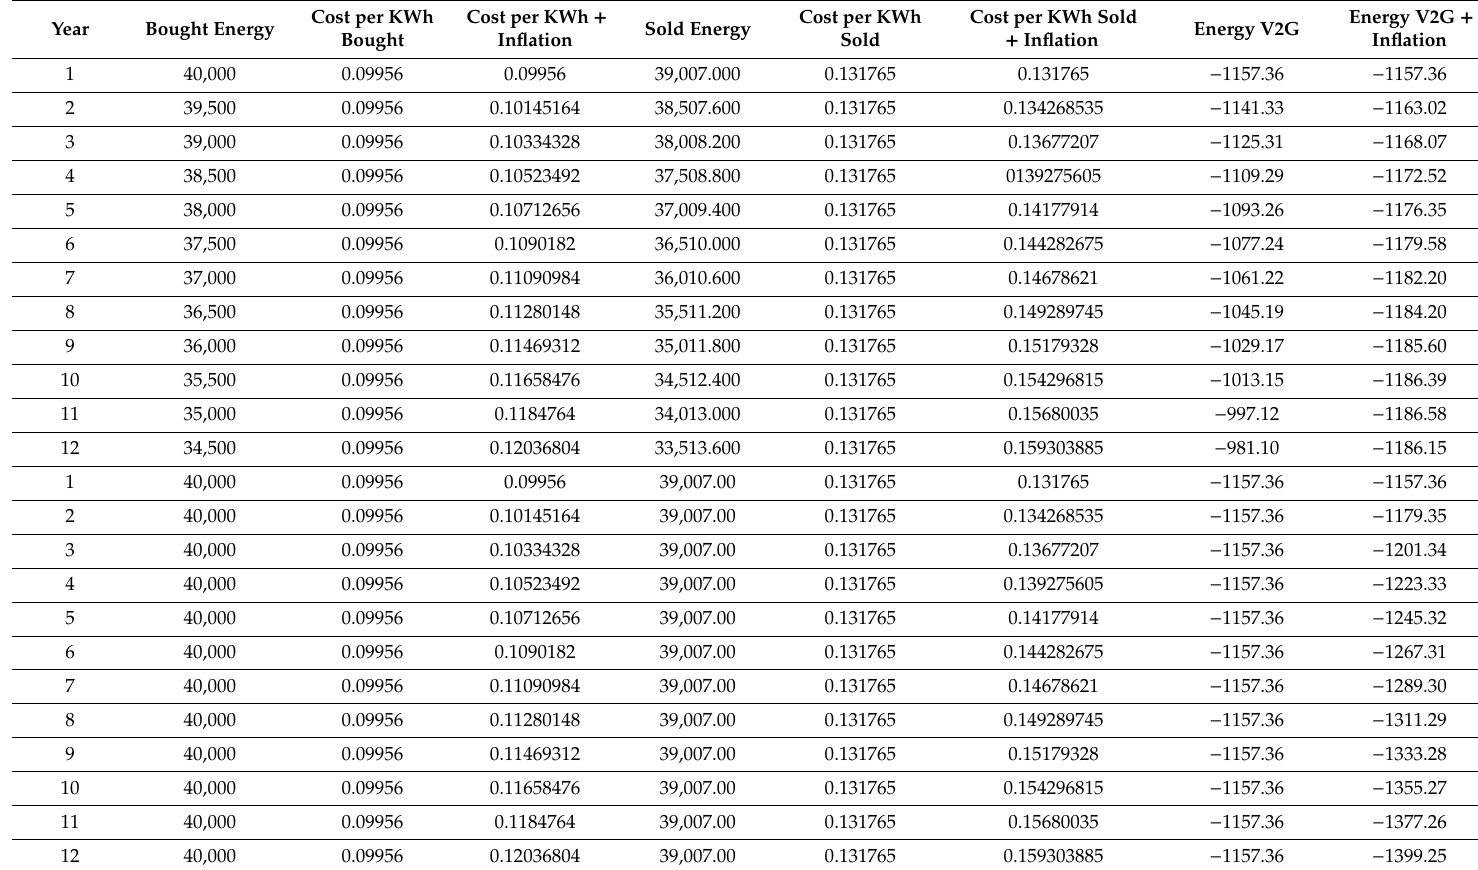
Table A7. Energy costs / profits with and without yearly degradation (occasional